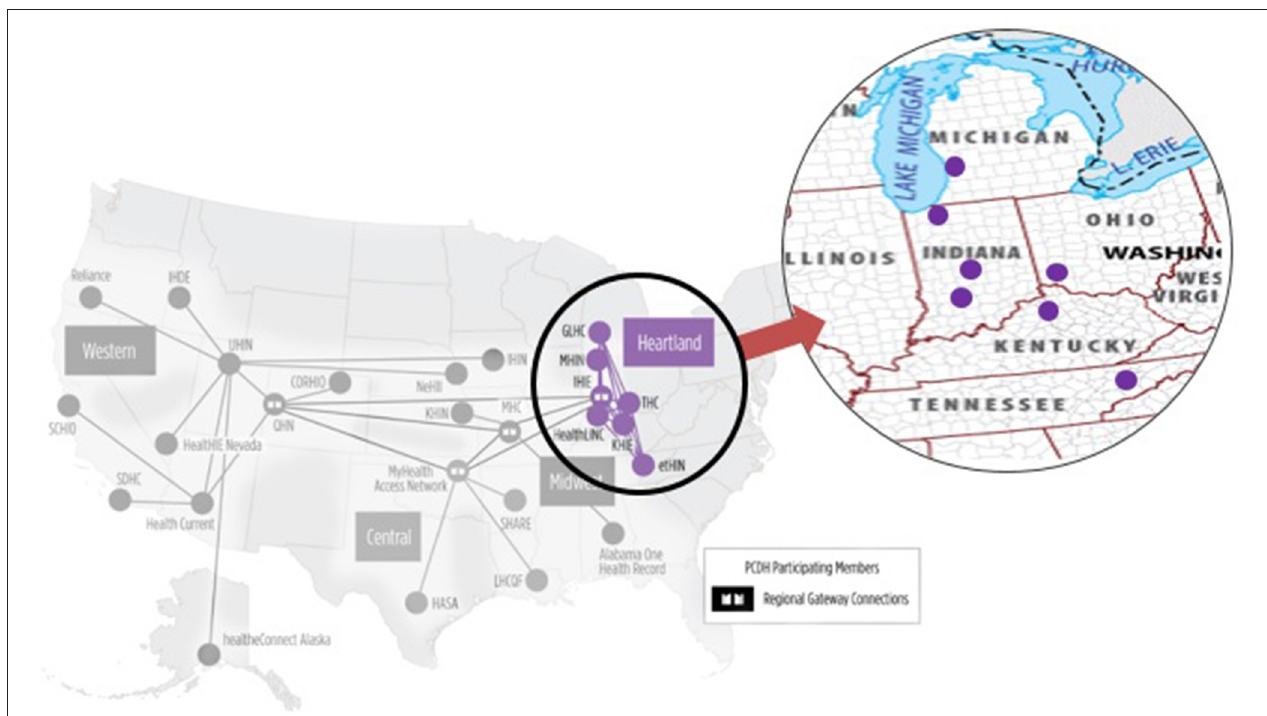
FIGURE 1 | Heartland region of patient-centered data home